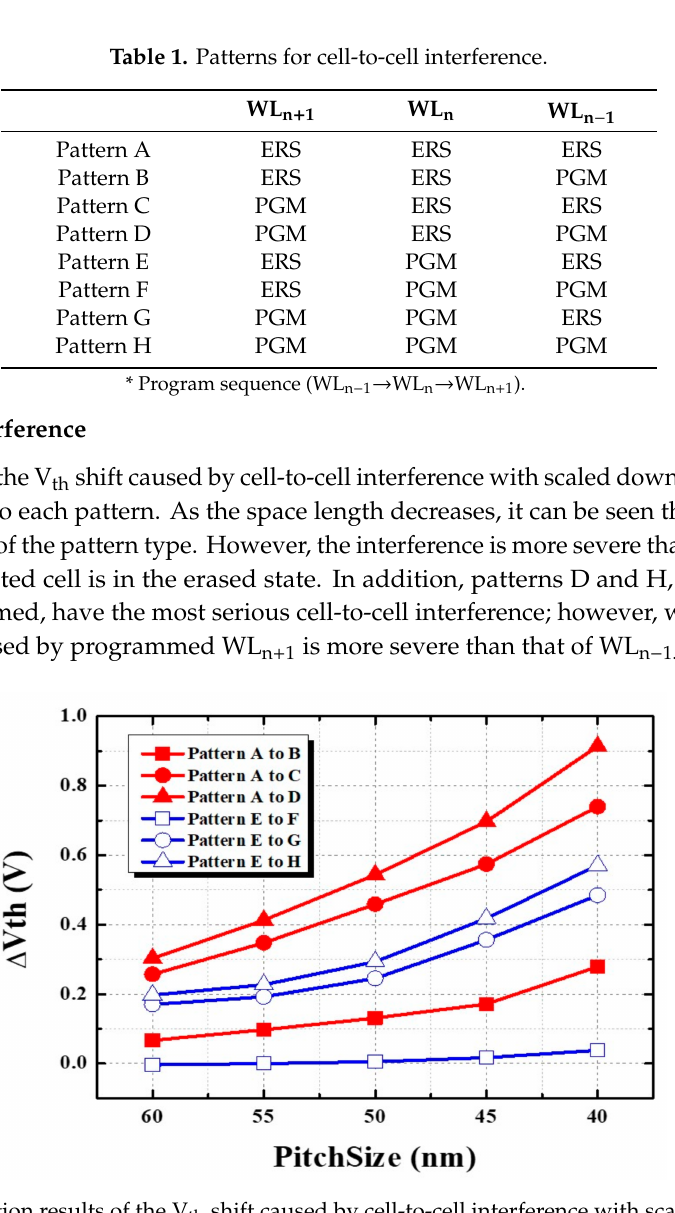
Figure 2. Simulation results of the V th shift caused by cell-to-cell interference with scaled down in 3D NAND flash memory according to each